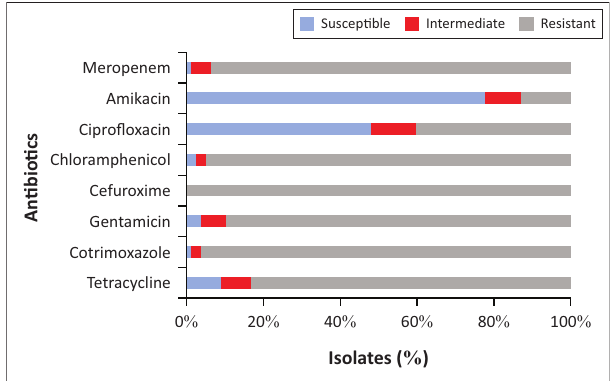
FIGURE 2: Antimicrobial resistance profile of Salmonella isolates from chickens from poultry farms in Ibadan metropolis, Nigeria, April 2018 – November